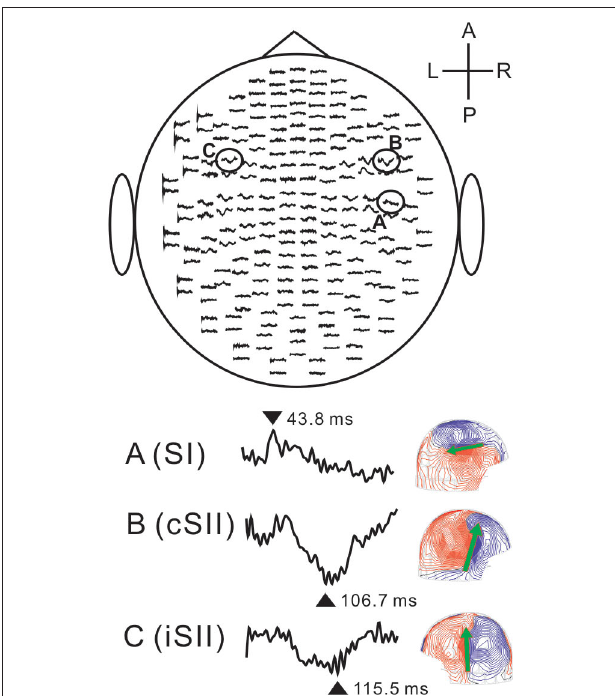
FIGuRE 4 | MEG signals for the left anterior (LA) stimulation of the tongue in a representative subject. The upper figure shows the SEF waveforms over 204 planar coils from the top of the head. Lower-left figures indicate enlarged waveforms recorded in three areas, A, B, and C. Lower-right figures show each magnetic field pattern at 43.8, 106.7, and 115.5 ms, respectively. The patterns are shown on the sensor array viewed from right (SI and cSII) and left (iSII). The arrows indicate the orientation of the ECD. Comparison between A (SI) and B (cSII) revealed clearly different field distributions and that the ECD of A (SI) was directed posteriorly, while the ECDs of B (cSII) were directed superiorly. L, left; R, right; A, anterior; P, posterior; SI, primary somatosensory cortex; cSII, secondary somatosensory cortex contralateral to the stimulation; iSII, secondary somatosensory cortex ipsilateral to the stimulation. Adopted from Sakamoto et al. (2008b).